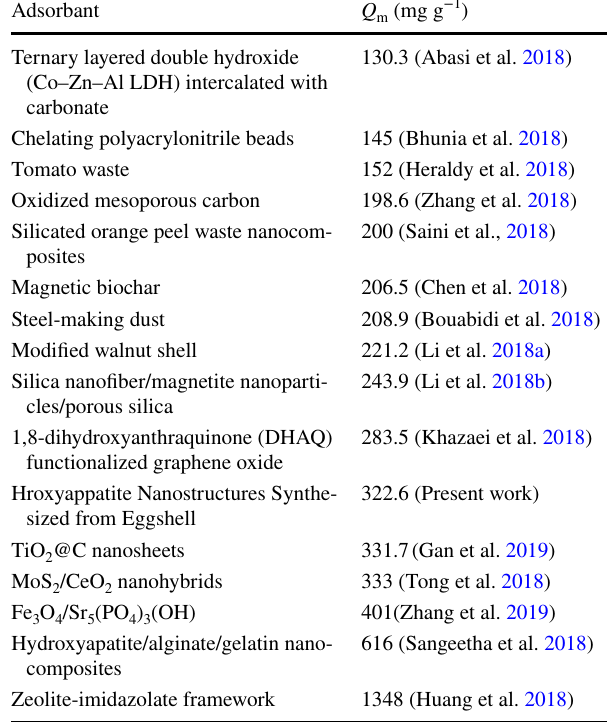
Fig. 4 a Langmuir and b Freundlich isotherms